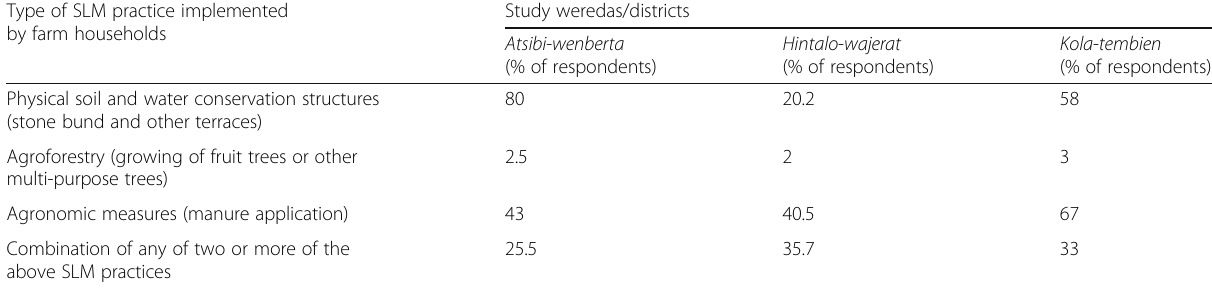
Study weredas/districts Atsibi - wenberta (% of respondents)